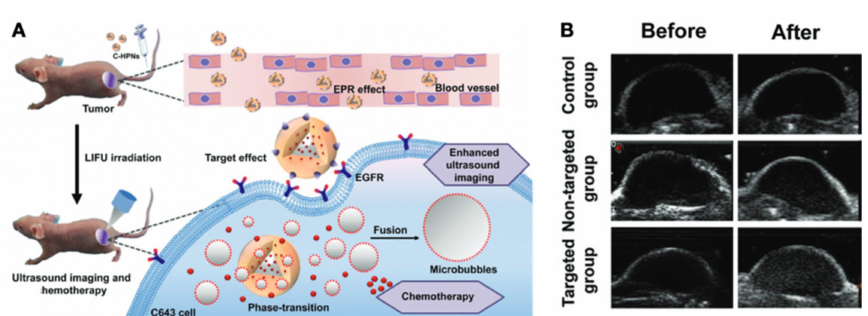
Figure 15. Theranostic applications of nanoparticles targeting EGFR. ( A ) Schematic illustration of the nanoparticles for chemotherapy drug delivery and enhanced diagnosis via LIFU. ( B ) Ultrasound imaging of tumors in B-mode before and after LIFU treatments. Reproduced with permission from [154], copyright 2019 Royal Society of